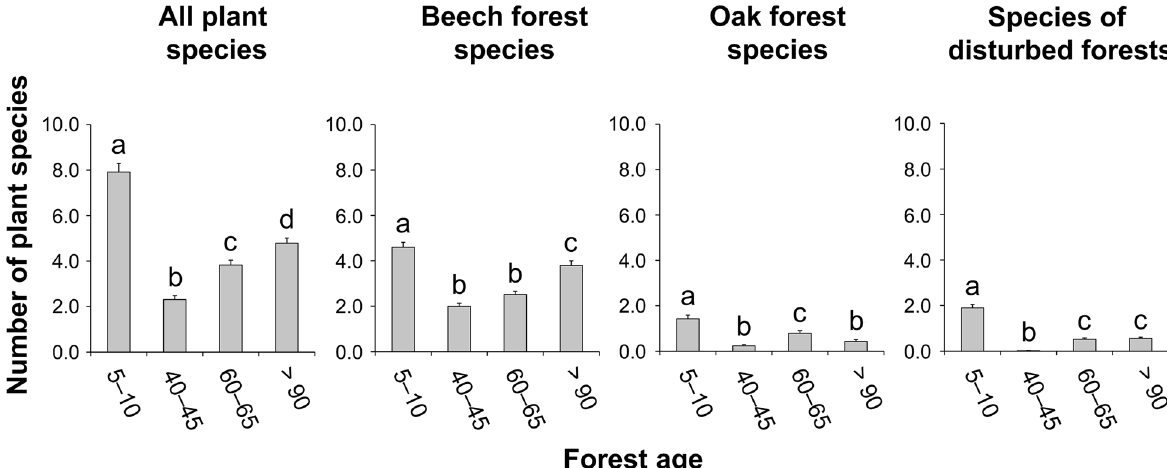
Fig. 4 Number of vascular plant species (all plant species, beech forest species, oak forest species, and species of disturbed forests) in the plots of dolines covered with different forest age classes (class 1: 5–10-year-old forest stands with mature forest patches, class 2: 40–45-year-old forests,